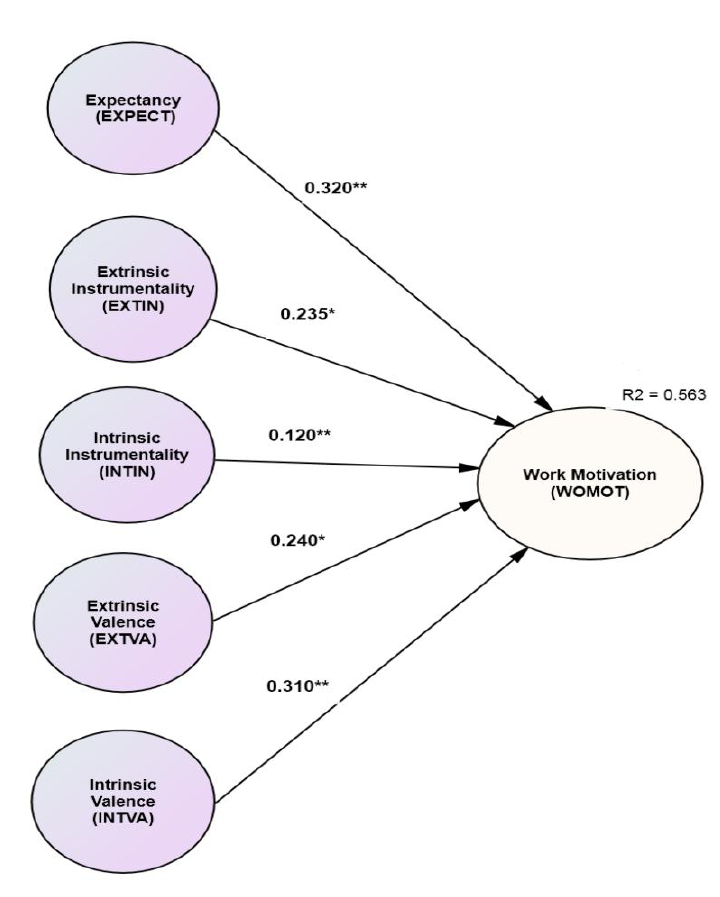
Figure 1 The structural